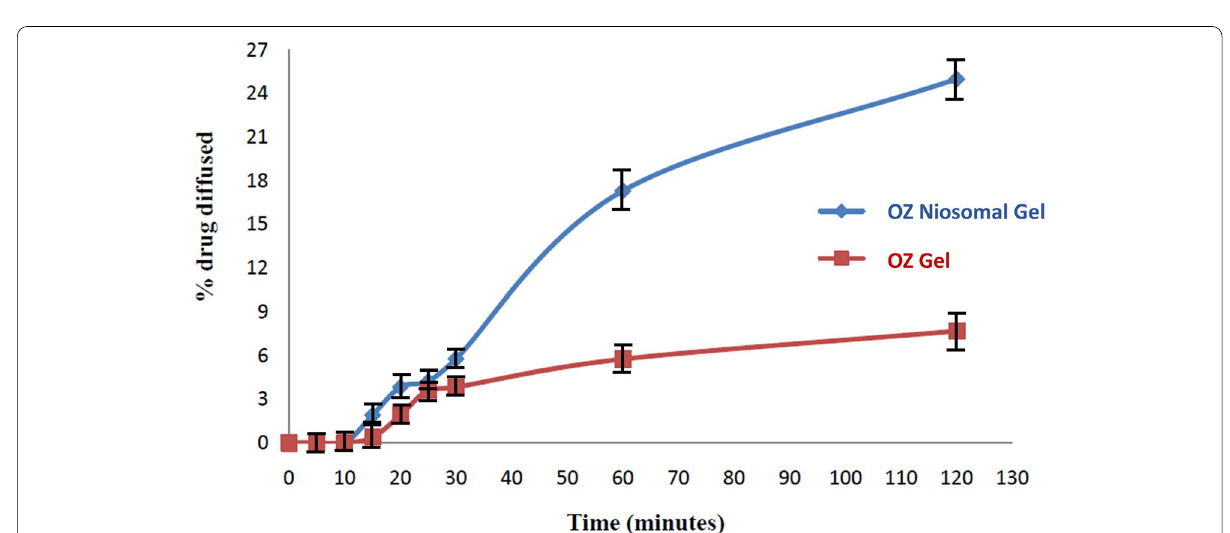
Fig. 4 Ex vivo permeation profile of (gamma oryzanol) OZ gel and optimized OZ niosomal